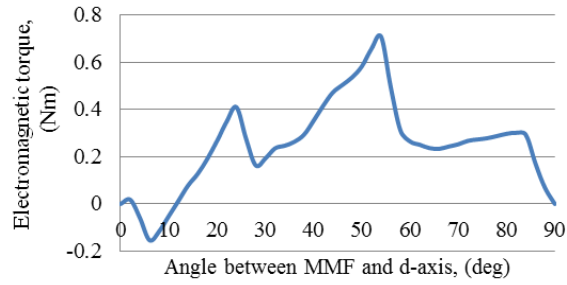
Fig. 10. Electromagnetic torque of the new design SynRM with segment- shaped outer rotor according to the angle between MMF vector and d-axis of the motor.